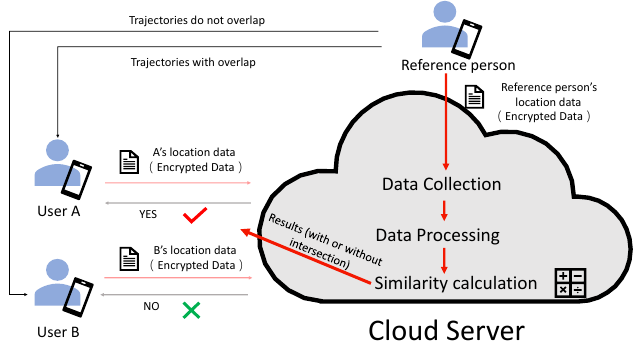
Figure 2. Data Interaction between IoT Devices and Cloud